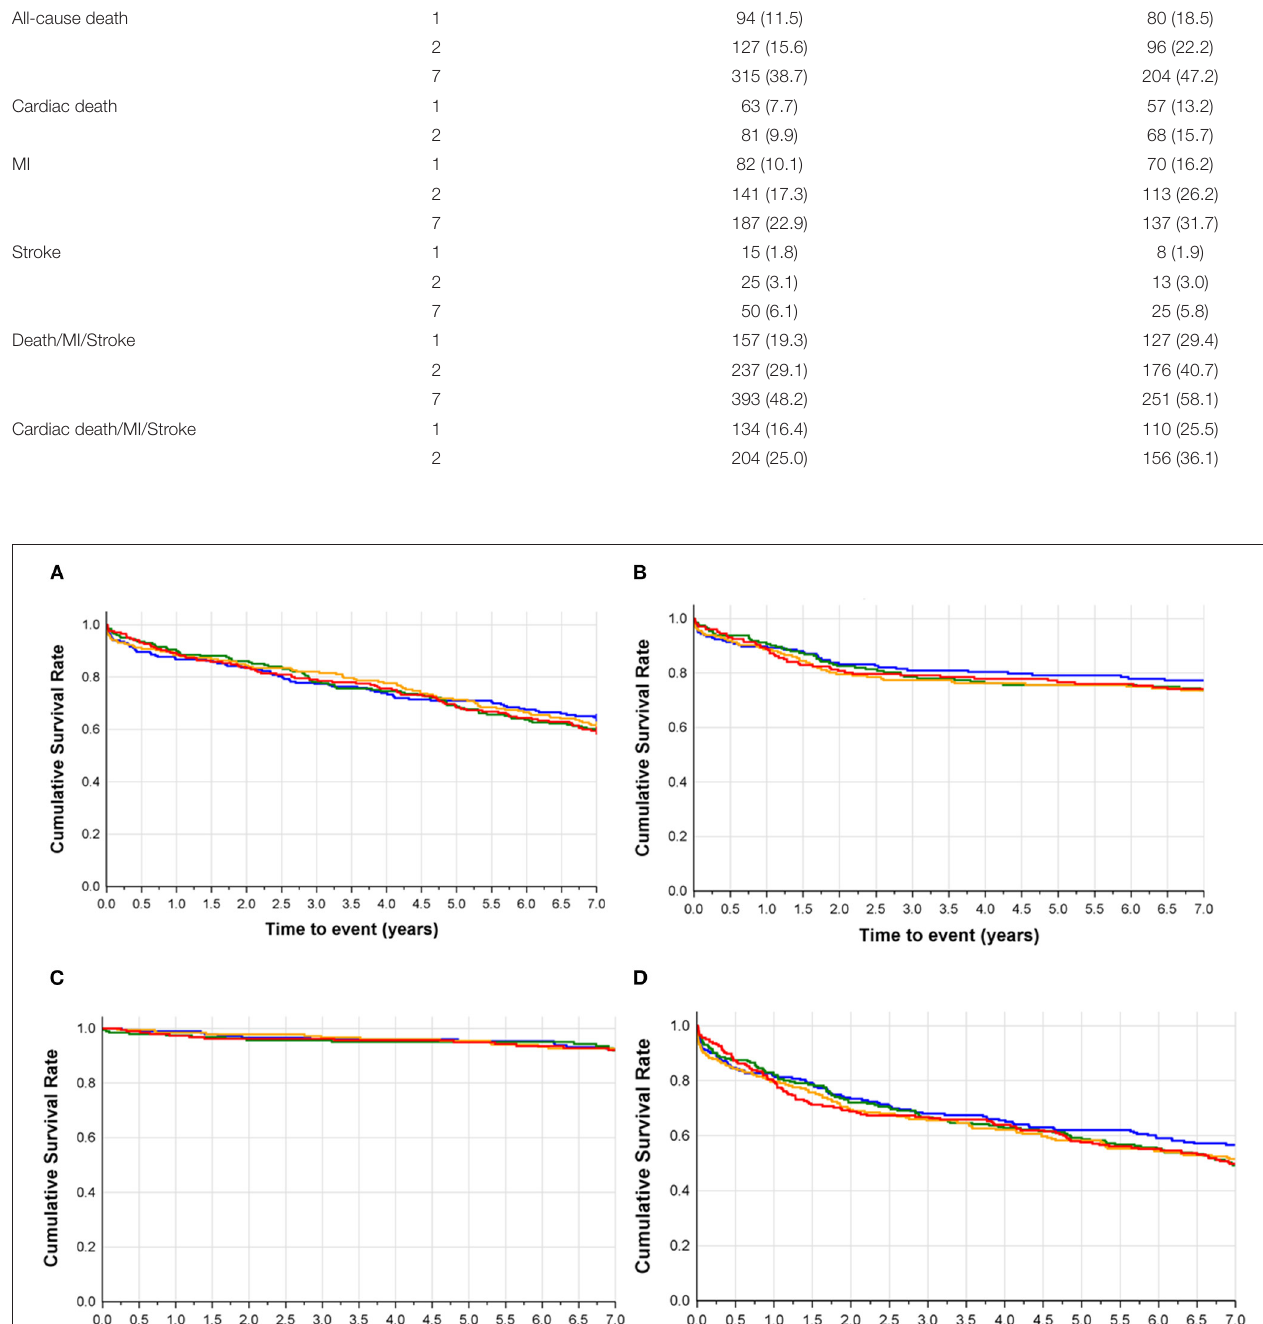
Frontiers in Cardiovascular Medicine |